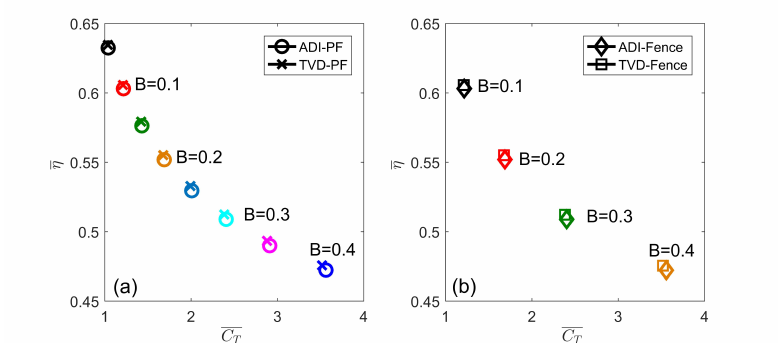
Figure 6. Turbine efficiency and thrust coefficient for partial fence ( a ) and fence ( b ) configurations obtained from ADI and